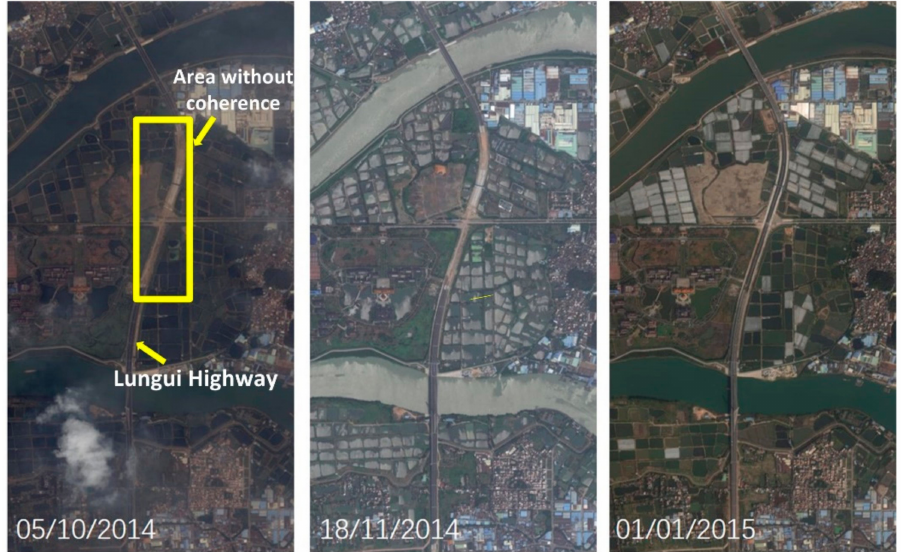
Figure 7. Study area on multi-temporal google maps. The area within the yellow rectangle was still under construction until December